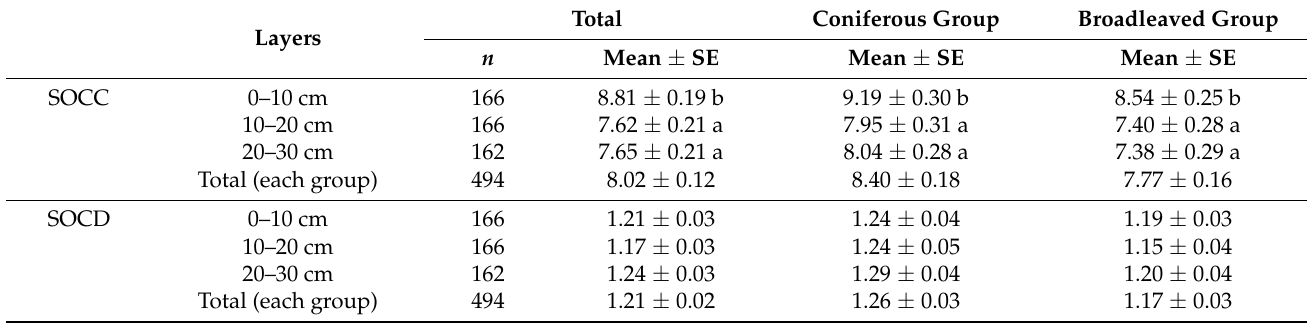
Table 1. SOCC (g kg − 1 ) and SOCD (kg m − 2 ) in the coniferous and broadleaved groups in three layers. Results are presented as means ± standard error. Abbreviations: SOCC, soil organic carbon concentration; SOCD, soil organic carbon density. Different letters in the same row of SOCC and SOCD indicate significant differences between layers at the 0.05